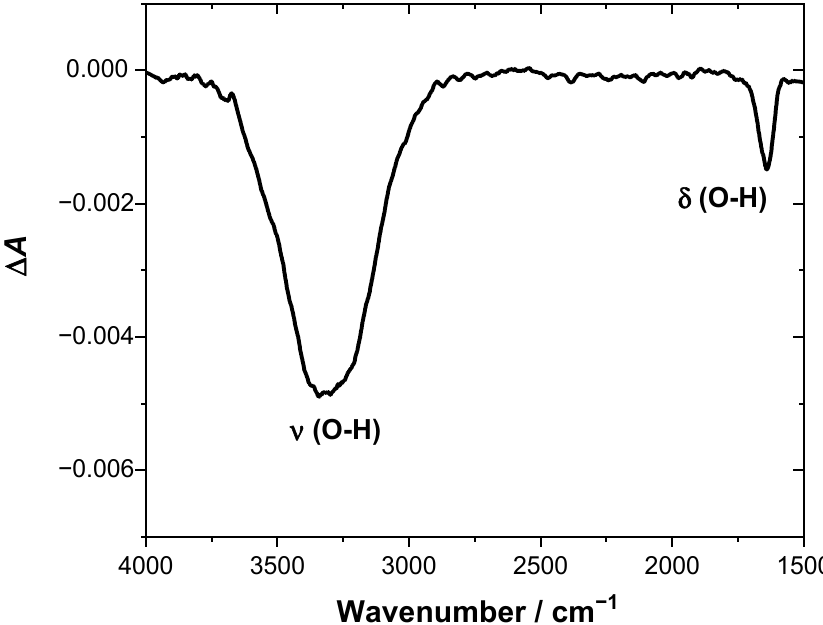
Figure 7. The SEIRA spectra representing the difference in the absorbance between the sample spectrum recorded after one freeze–thaw cycle and the reference spectrum collected before the freeze–thaw cycle. Negative v (O–H) and δ (O–H) bands are indicative of loss of water at the electrode–electrolyte interface.